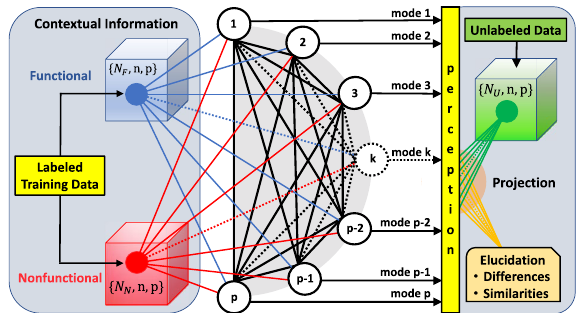
Figure 1. Schematic of SPLOC as a recurrent neural network and data flow. For p variables there are p perceptrons, labeled from 1 to p , comprising the input layer that receives N F functional and N N nonfunctional data packets of n samples. Each perceptron maps to a mode, and has access to all data packets organized in the form of two types of data packet cubes. Each perceptron recurrently interacts with all other perceptrons through competitive learning. The basis set rotates as the neural network evolves to maximize efficacy. Upon convergence, all perceptrons comprise the output layer for the specification of an orthonormal complete basis set. A rectifying function is assigned to each perceptron, defining a viewpoint for controlling sensitivity and selectivity in feature extraction. For a given viewpoint, the final basis set defines perception when the neural network achieves maximum efficacy. Unlabeled data packets are subsequently classified within the context of training data, having multivariate discriminant and conserved features that are readily